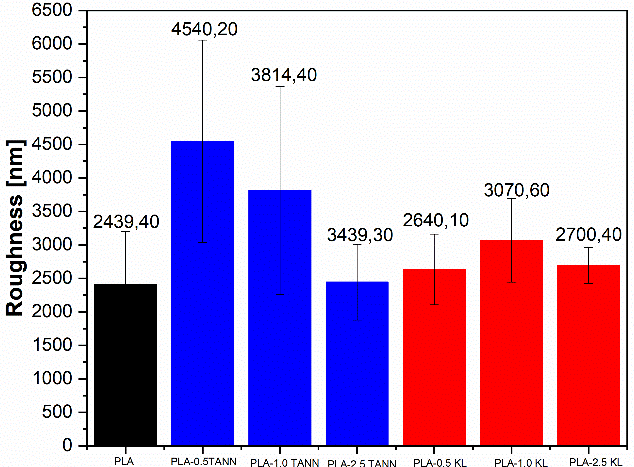
Figure 3. An average roughness value of neat PLA, PLA-TANN, and PLA-KL composites. In general, the trend of change in the water contact angle of PLA-KL and PLA-TANN composites agrees well with that of surface roughness, indicating the distribution of KL and TANN in PLA composites and varies in different deep layers of PLA-KL and PLA- TANN composites (Figure 4). From the correlation plot between CA and roughness (Fig- ure 4), the correlation coefficient for PLA-TANN is high (0.973), indicating higher linear strength, while the lowest correlation coefficient is calculated for PLA-KL (0.715), which is still considered strong. Figure 4. Correlation between CA and roughness of PLA-KL and PLA-TANN composites. Surface charge expresses the interaction between PLA composites in aqueous solu- tion and solid surfaces and is a key factor in explaining the differences between PLA com- posites before and after incorporation of the polyphenolic fillers. Therefore, the surface properties of PLA-based polyphenolic filler as varying the filler types and filler content were followed by zeta potential measurements. Figure 5a,b presents the zeta potential values of the neat PLA, PLA-KL, and PLA-TANN composites with addition of polyphe- nolic filler as a function of pH ranging from 2 to 12. The isoelectric point and the value of zeta potential are indicators of the functional groups present on the surface of the PLA composites. The decrease of the isoelectric point indicates the addition of acidic groups,